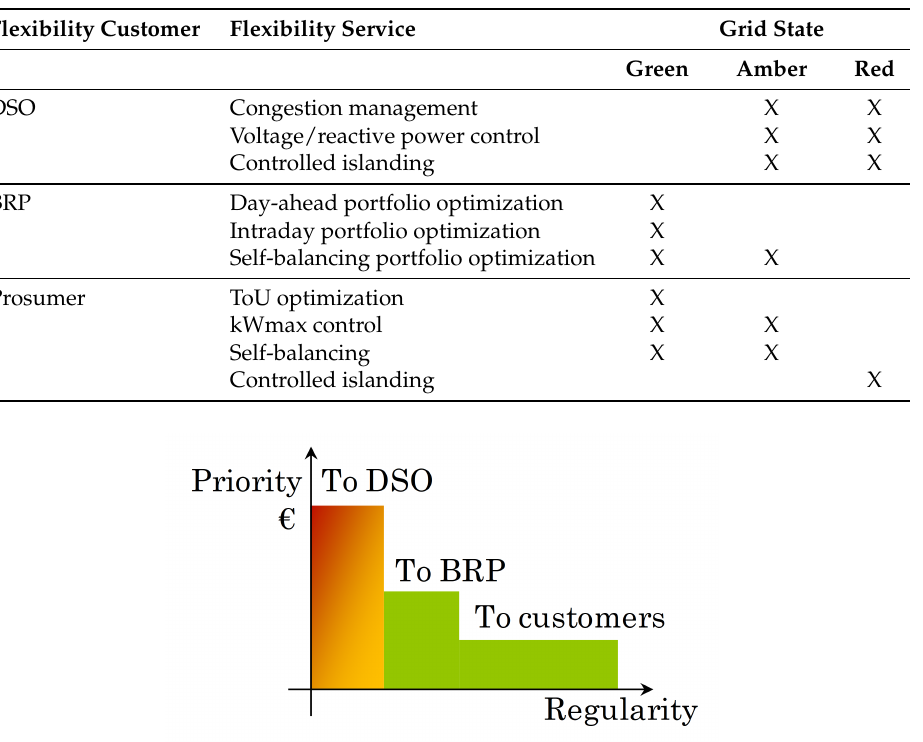
Table 1. Flexibility services to be offered in each grid state by local energy communities.